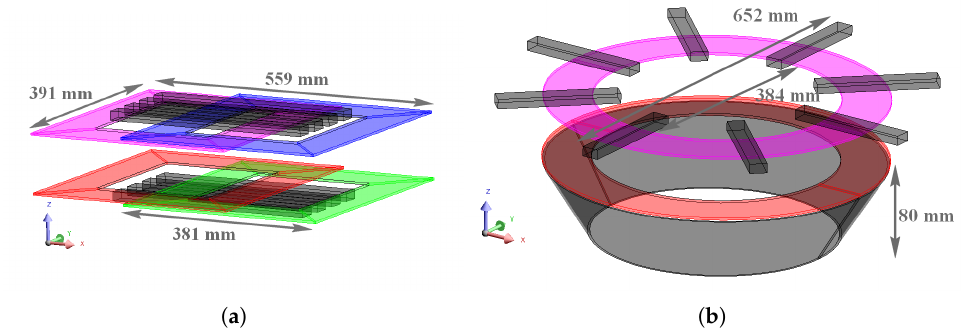
Figure 2. Magnetic coupler geometries: ( a ) Bipolar pad (BPP), ( b ) Ferrite-less circular pad